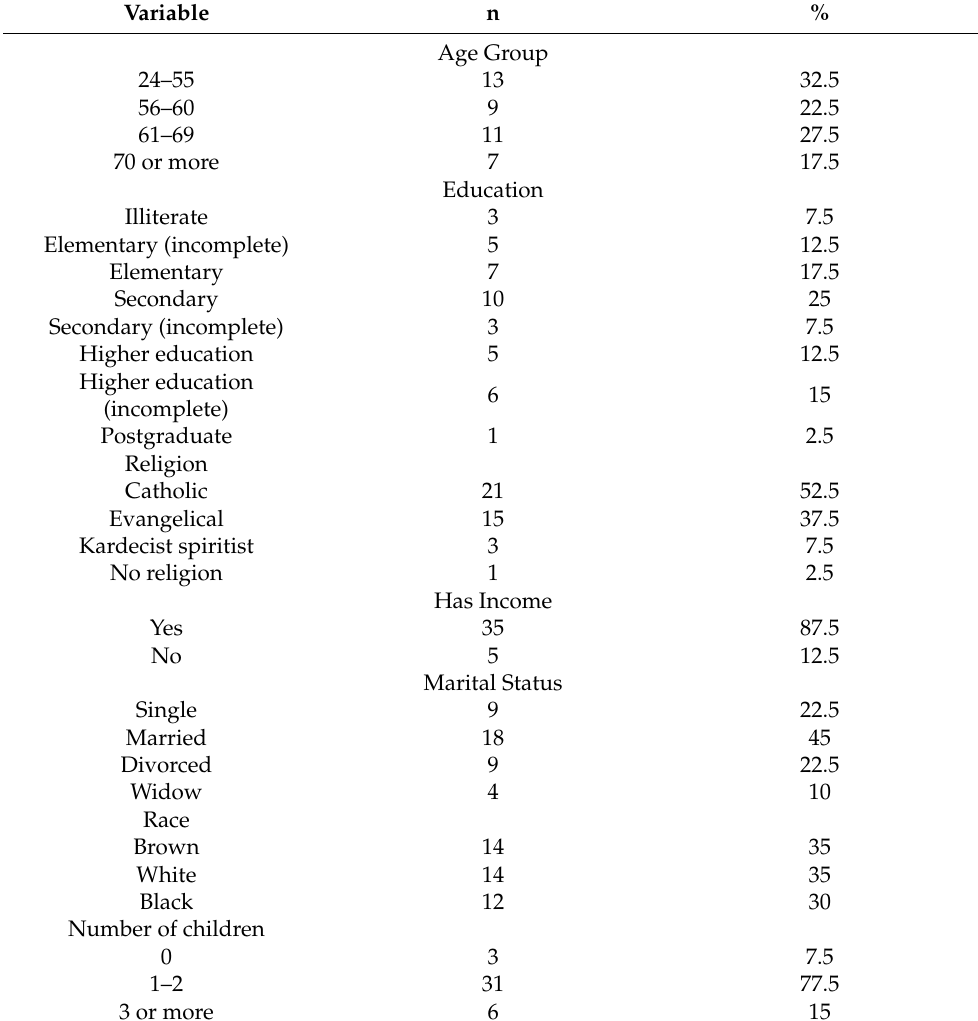
Table 1. Distribution of the sociodemographic and religious variables of the